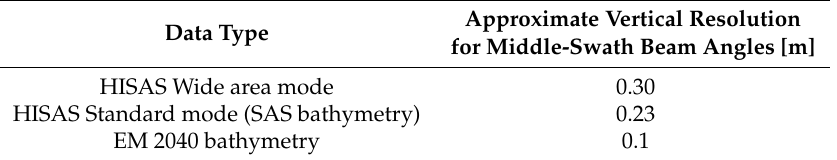
Table 14. Approximate vertical resolution for middle-swath beam